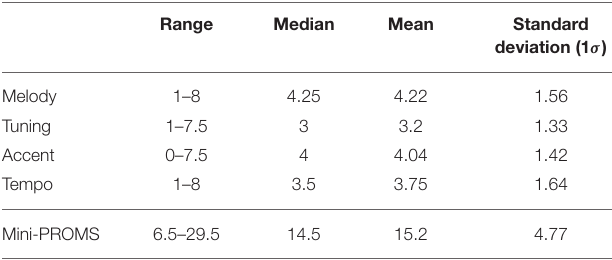
TABLE 8 | Mini-PROMS range, median, mean, and standard